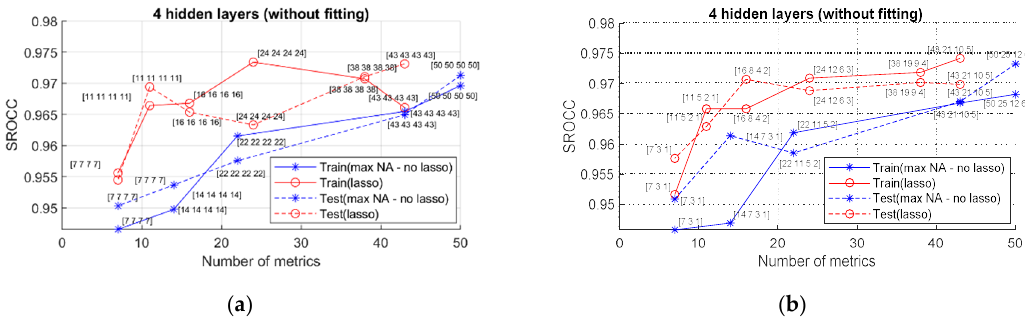
Figure 5. SROCC values for NNs with four hidden layers with different numbers of inputs: ( a ) equal number of neurons in hidden layers; ( b ) twice smaller number of neurons in hidden layers.